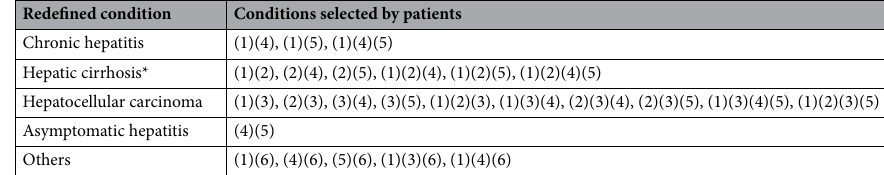
Table 1. Disease classification of hepatitis-related conditions. (1) chronic hepatitis, (2) hepatic cirrhosis, (3) hepatocellular carcinoma, (4) viral carrier, (5) fatty liver, and (6) others. *Patients who had at least one of the following conditions were diagnosed with decompensated cirrhosis: ascitic fluid, encephalopathy, or albumin level ≤ 3.0 g/dL. Others were diagnosed with compensated